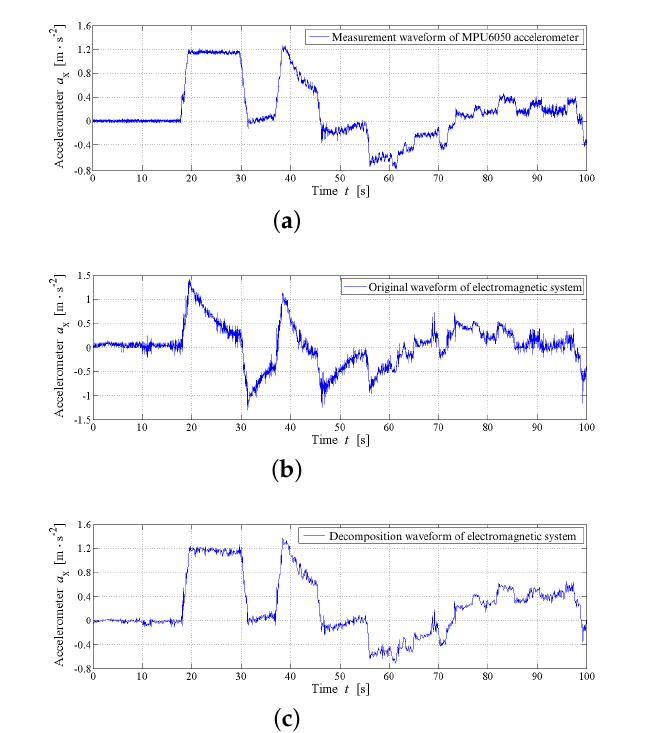
Figure 9. Metro acceleration measurement waveforms: ( a ) MPU6050 accelerometer measurement waveform; ( b ) original waveform of electromagnetic system; ( c ) decomposition waveform of electromagnetic